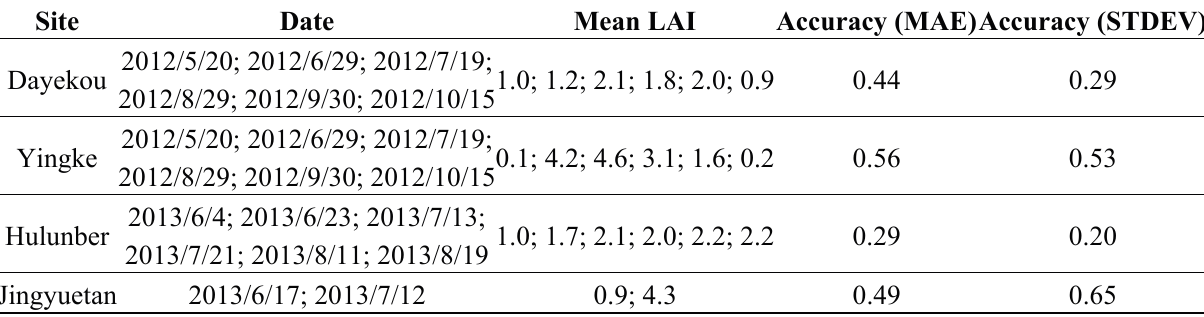
Table 3. Characteristics of the LAI reference maps for the validation sites (“STDEV” under “Accuracy (STDEV)” refers to the standard